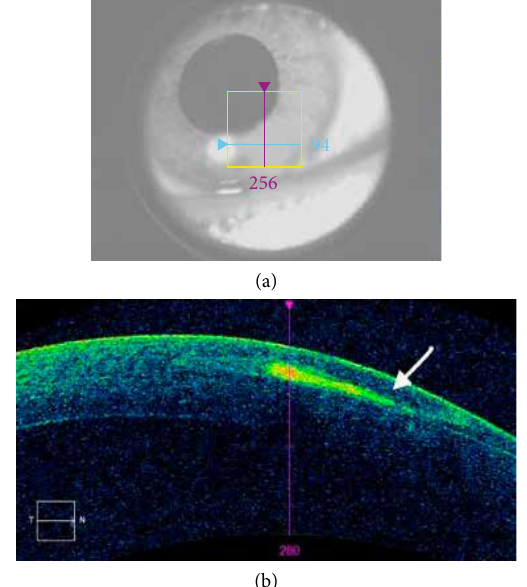
Figure 2: (a) Corneal area imaged by the Optical Coherence Tomography (OCT). (b) The OCT showing the epithelial tract under the flap at 5 o’clock